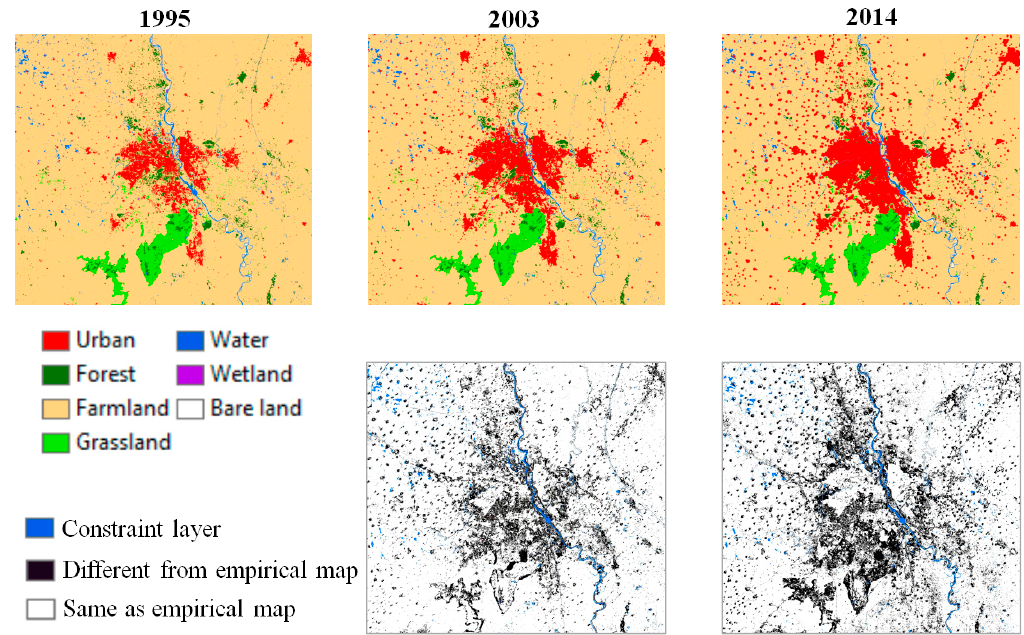
Figure 6. The simulated LULC maps and error maps.